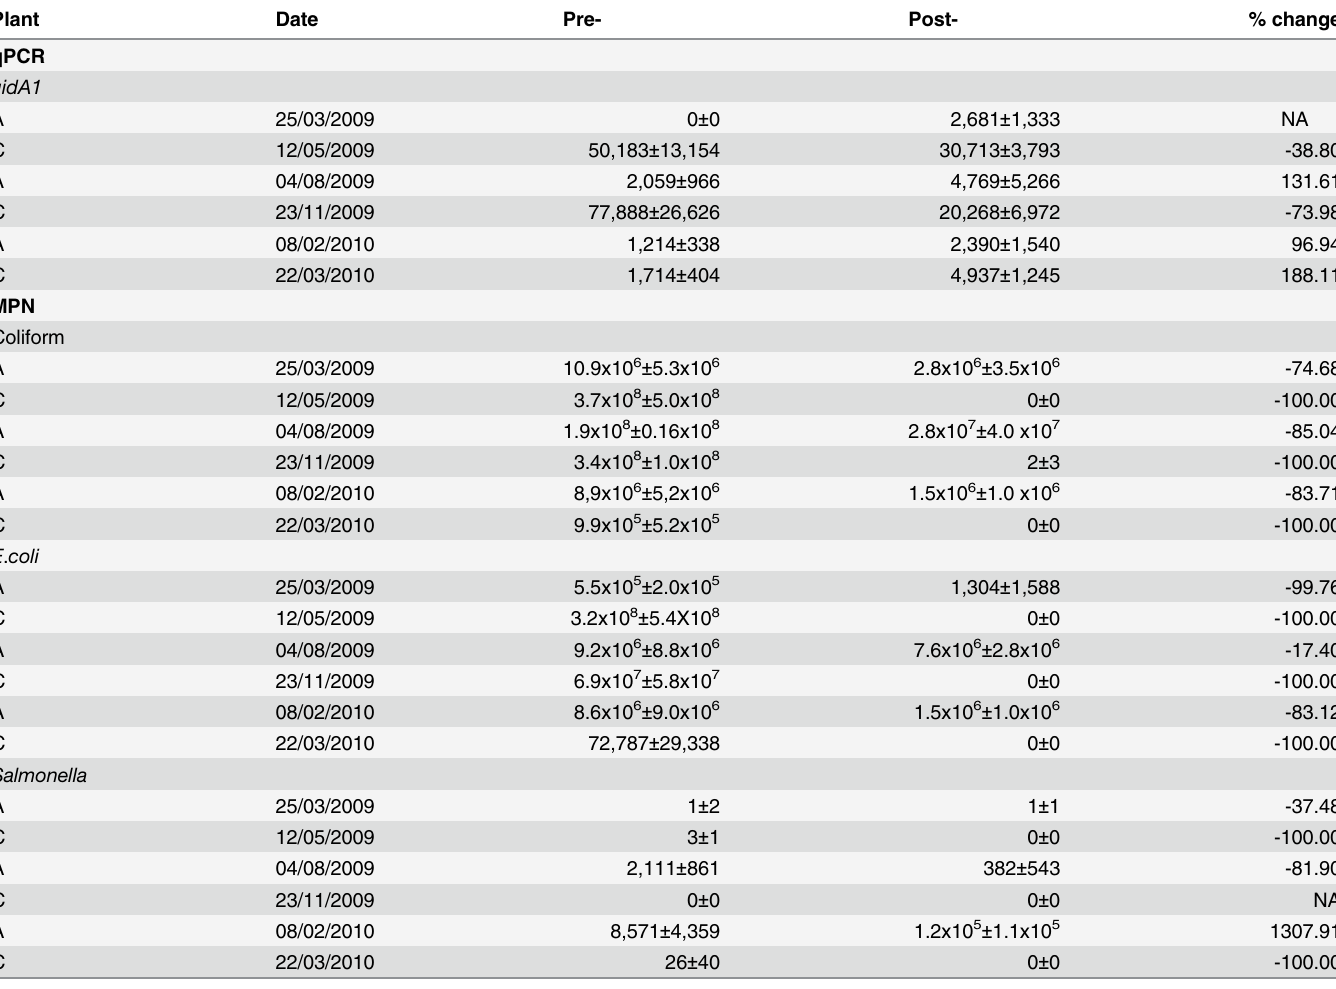
Table 6. Mean ( ± SD) abundance of E . coli , coliforms and Salmonella based on qPCR (per g) and MPN counts (per 10 g).